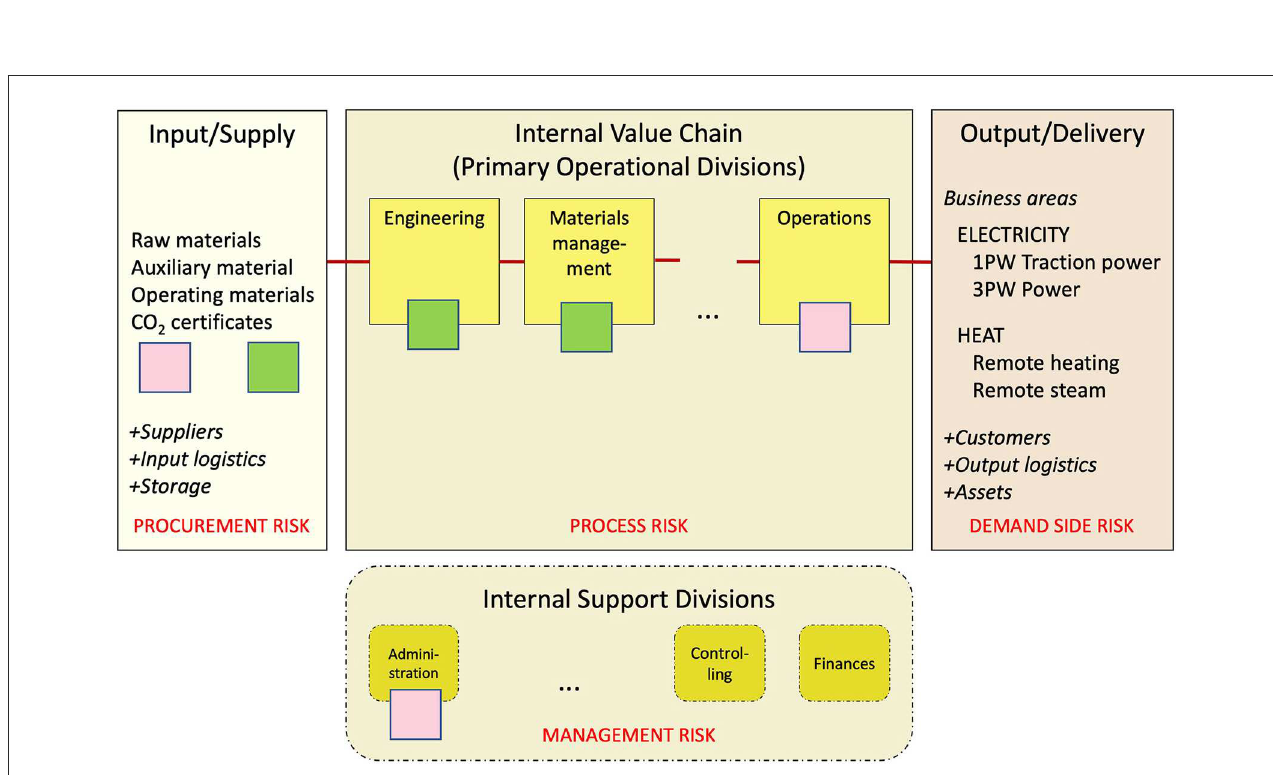
FIGURE5 Scheme of the corporate value chain enriched with risk factors. For each group of units, activities, and processes, a group of associated risk factors is designated. Each such element of the value chain may have any number of assigned capacities (green squares) and sensitivities (pink squares). The full enriched value chain created in the case study is